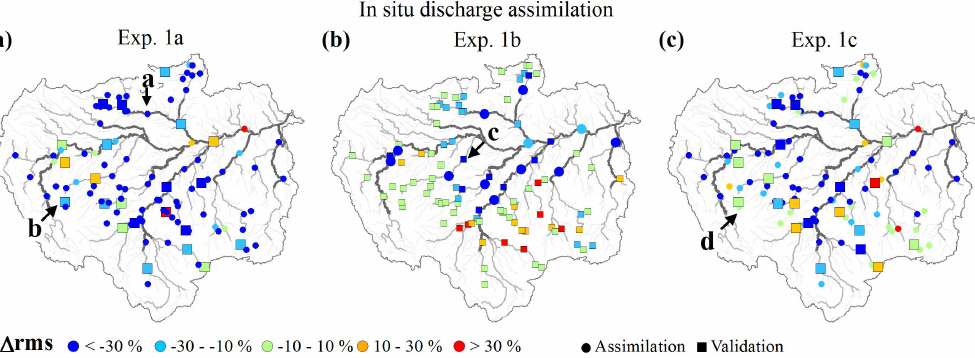
Fig. 2. Evaluation of in situ discharge assimilation. Spatial distribution of change in root-mean-square error ( 1 rms) in stream gauges used for data assimilation (circles) and validation (squares) considering the assimilation of (a) almost all gauges (Exp. 1a), (b) only 12 gauges (Exp. 1b) and (c) almost all gauges but without log transformation (Exp. 1c). Table 1. Summary of the performance of in situ discharge data assimilation (Exp. 1): median Nash and Suttcliffe index ( E NS ) in simulation (Open-loop) and assimilation (EnKF) modes and mean change in root-mean-square error ( 1 rms). Exp. 1a b Exp. 1b c Exp. 1c d Sites E NS 1 rms (%) E NS 1 rms (%) E NS 1 rms (%) Open-loop 0.68 – 0.68 – 0.68 – All EnKF 0.93 − 42 0.72 − 8 0.85 − 25 Open-loop 0.71 − 0.89 − 0.71 – Assimilation EnKF 0.94 − 49 0.98 − 51 0.88 − 29 Open-loop 0.60 − 0.65 − 0.60 Validation EnKF 0.73 − 16 0.67 − 3 0.67 − 10 Open-loop 0.79 0.79 Large rivers a EnKF 0.94 − 34 0.87 − 23 0.95 −